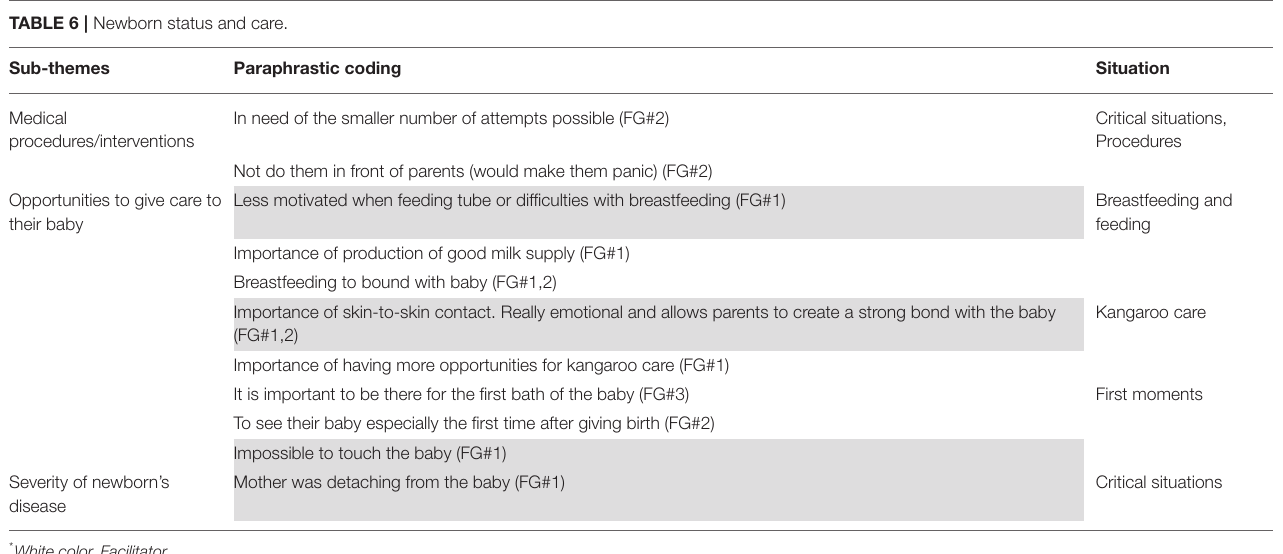
TABLE 6 | Newborn status and care.